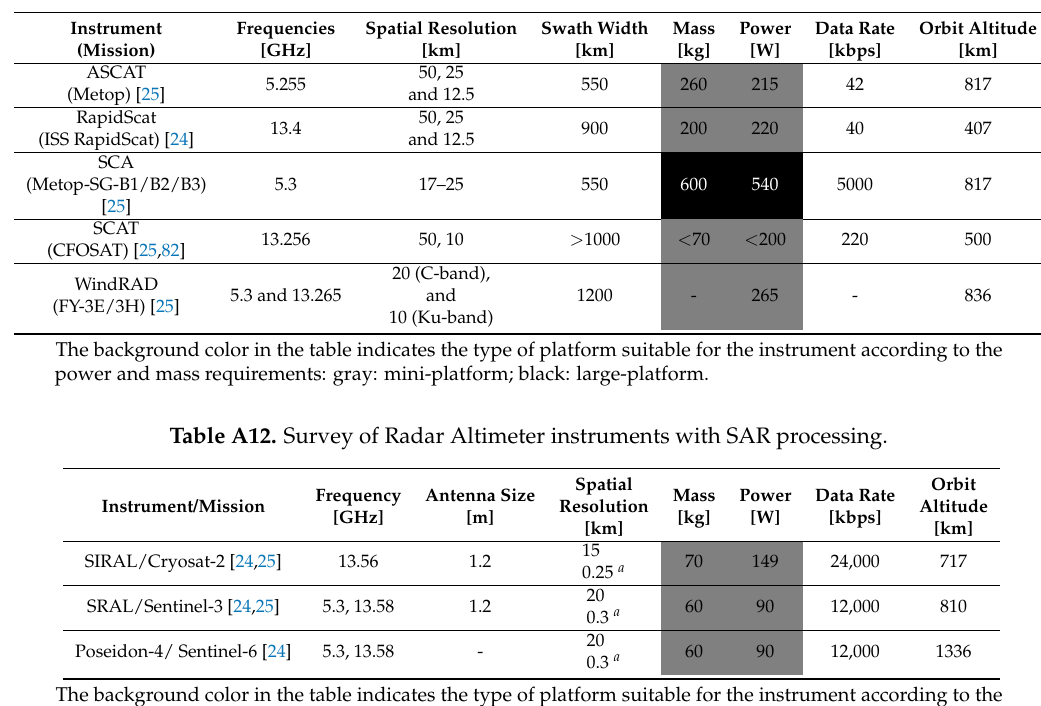
Table A11. Survey of scatterometer instruments.